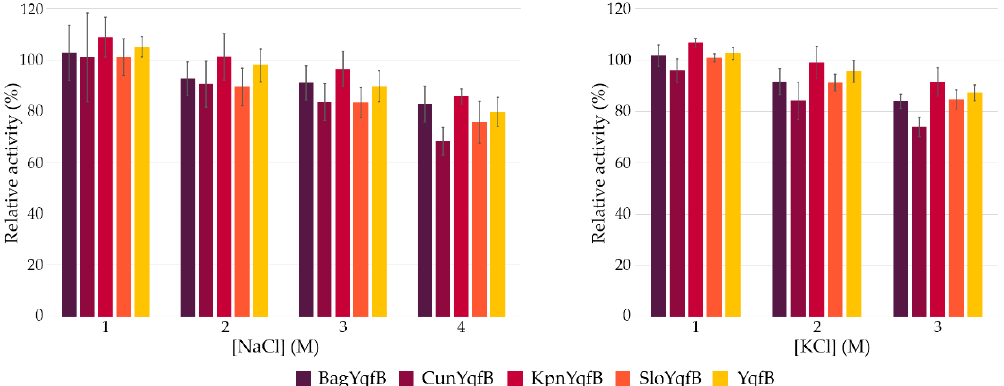
Figure 2. Effect of NaCl and KCl on the activity of ASCH domain-containing proteins. The activity without added salts was taken as 100%. The substrate used in these experiments was ac4C.